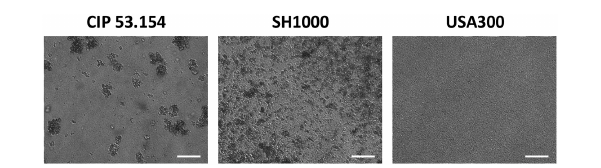
FIGURE 1 | Different biofilm structures according to S. aureus strains. Biofilms were grown aerobically for 24 h in minimal medium and imaged by light microscopy. Representative images are shown. The scale bars indicate 40 µ